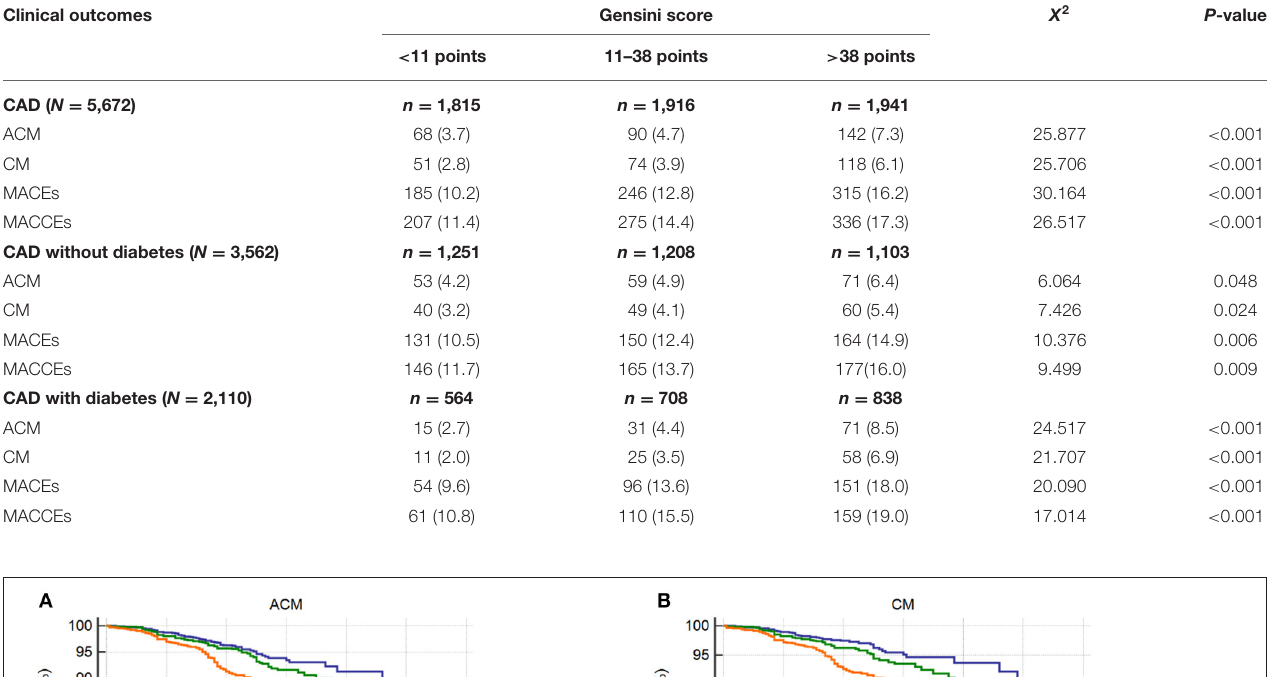
TABLE 3 | Clinical outcomes and Gensini score according to tertiles.